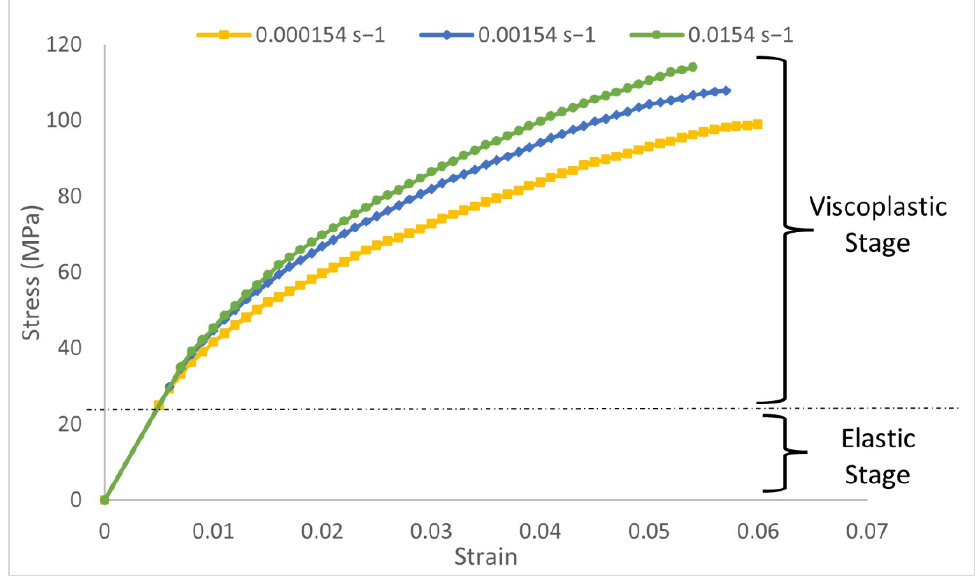
Figure 1. Stress-strain curves of flax/PLA biocomposite obtained in tensile tests at different strain rates.